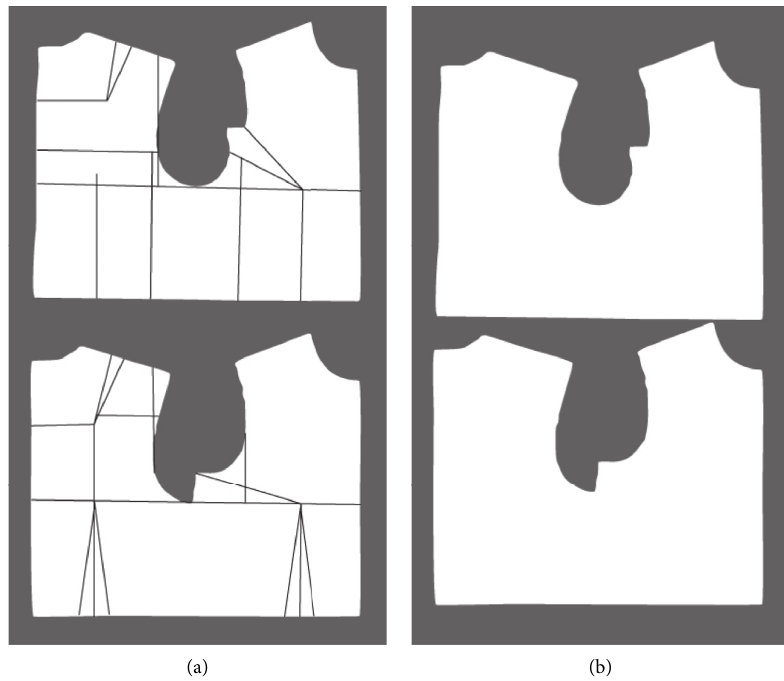
Figure 1: Clothing sample (a) and denoising effect diagram